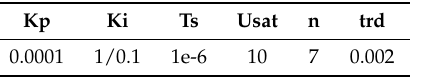
Figure A7. Time domain circuit model of the Type D LED lamp. Table A1. LED Type D: Proportional Integral (PI) control parameters.